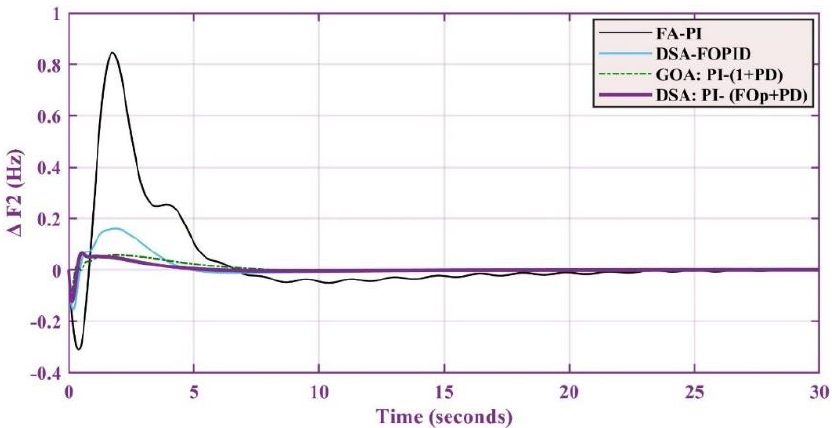
Figure 10. Response at 2.5% load change at area-2 .